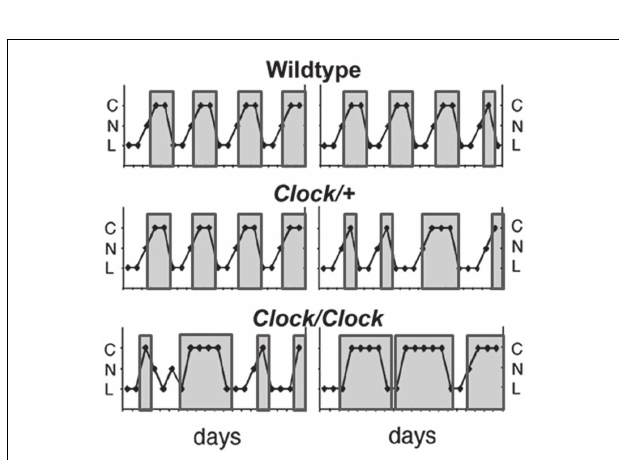
FIGURE 3 | Model of the interaction between the daily timing signal and the ovarian signal on GnRH release . AVP is rhythmically transcribed in the SCN and forms the basis for the strong neural daily timing signal from the SCN. On the day of proestrus, estradiol produced by the developing follicles in